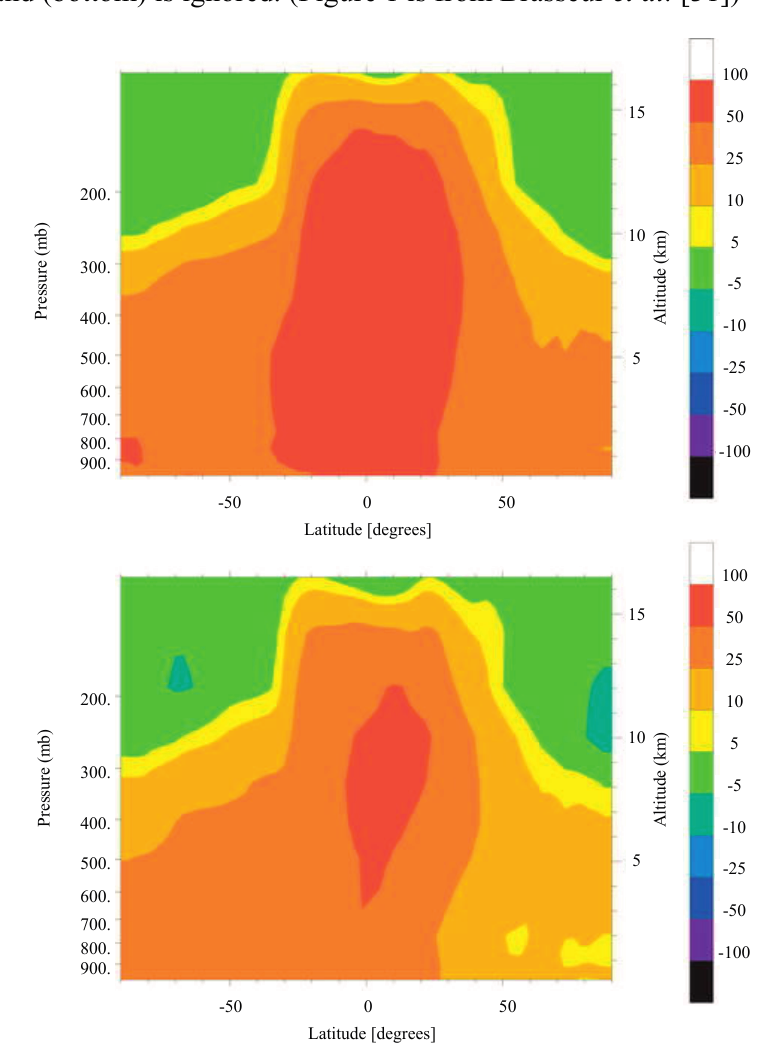
Figure 1. Percent change in the July zonally averaged ozone concentration between years 2000 and 2100, when the adopted change in the methane level (top) is included in the calculations and (bottom) is ignored. (Figure 1 is from Brasseur et al.